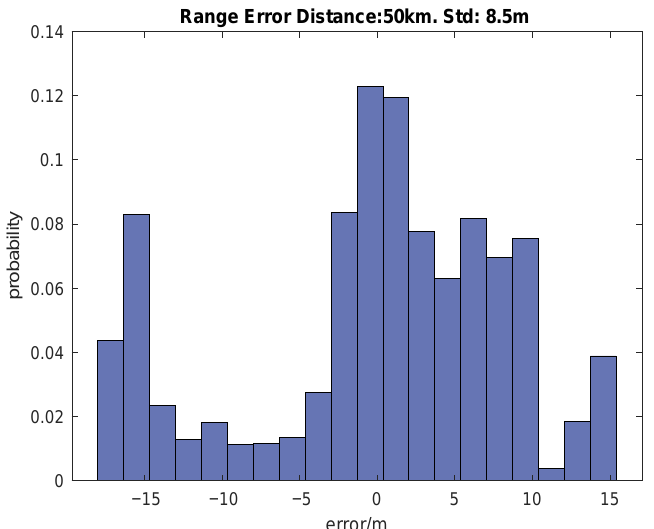
Figure 4. The histogram of the error in the acoustic OWTT range